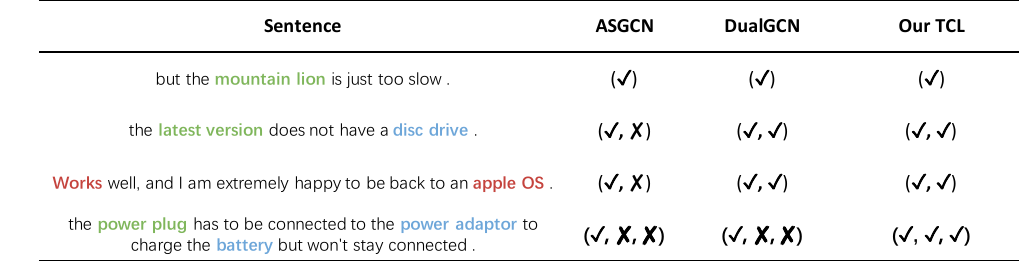
Figure 5. Case study. ALSC results of TCL, ASGCN and DualGCN on testing examples, along with their predictions and correspondingly, golden labels. The marker (cid:33) and (cid:37) indicate the correct classification and incorrect classification,